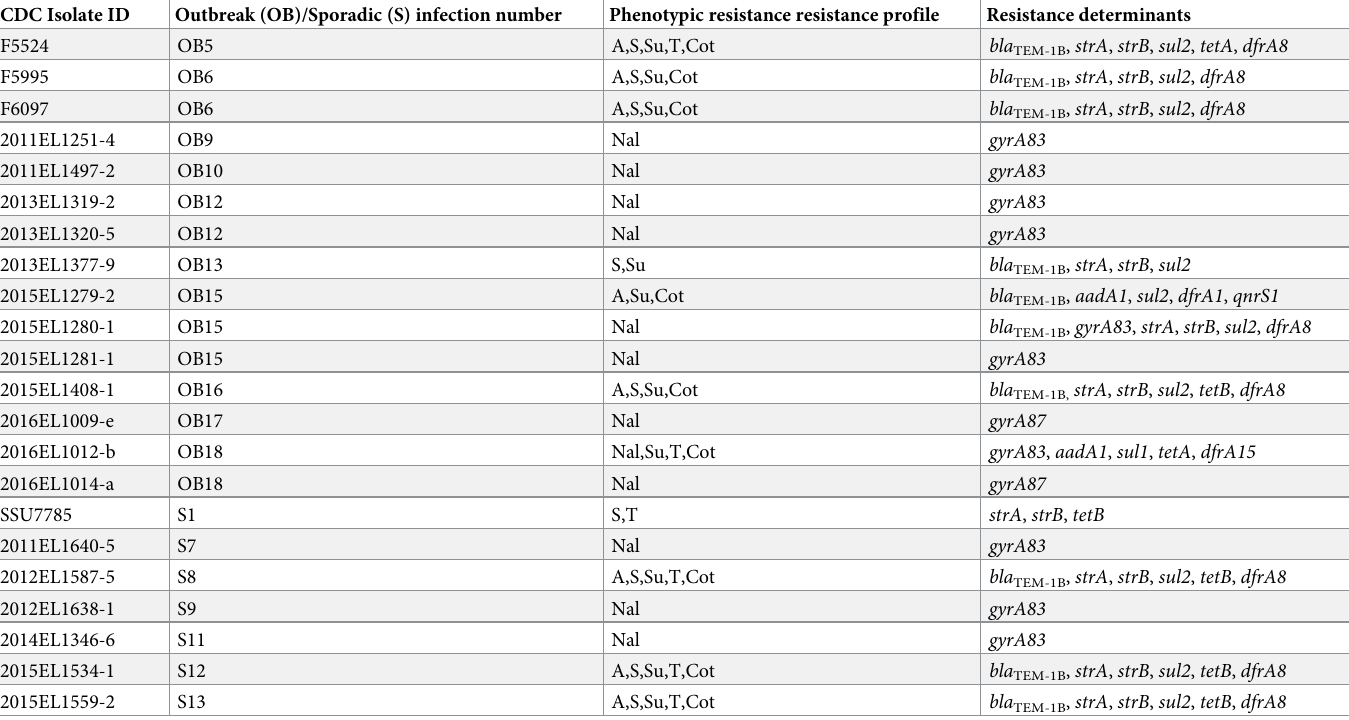
Table 3. Phenotypic and genotypic antimicrobial resistance profiles of ETEC O6 isolates. CDC Isolate